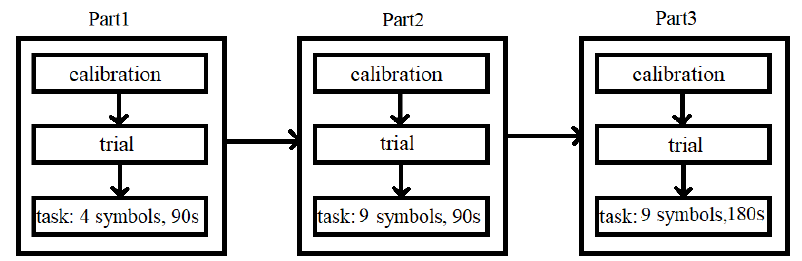
Figure 1. The procedure of the experiment.